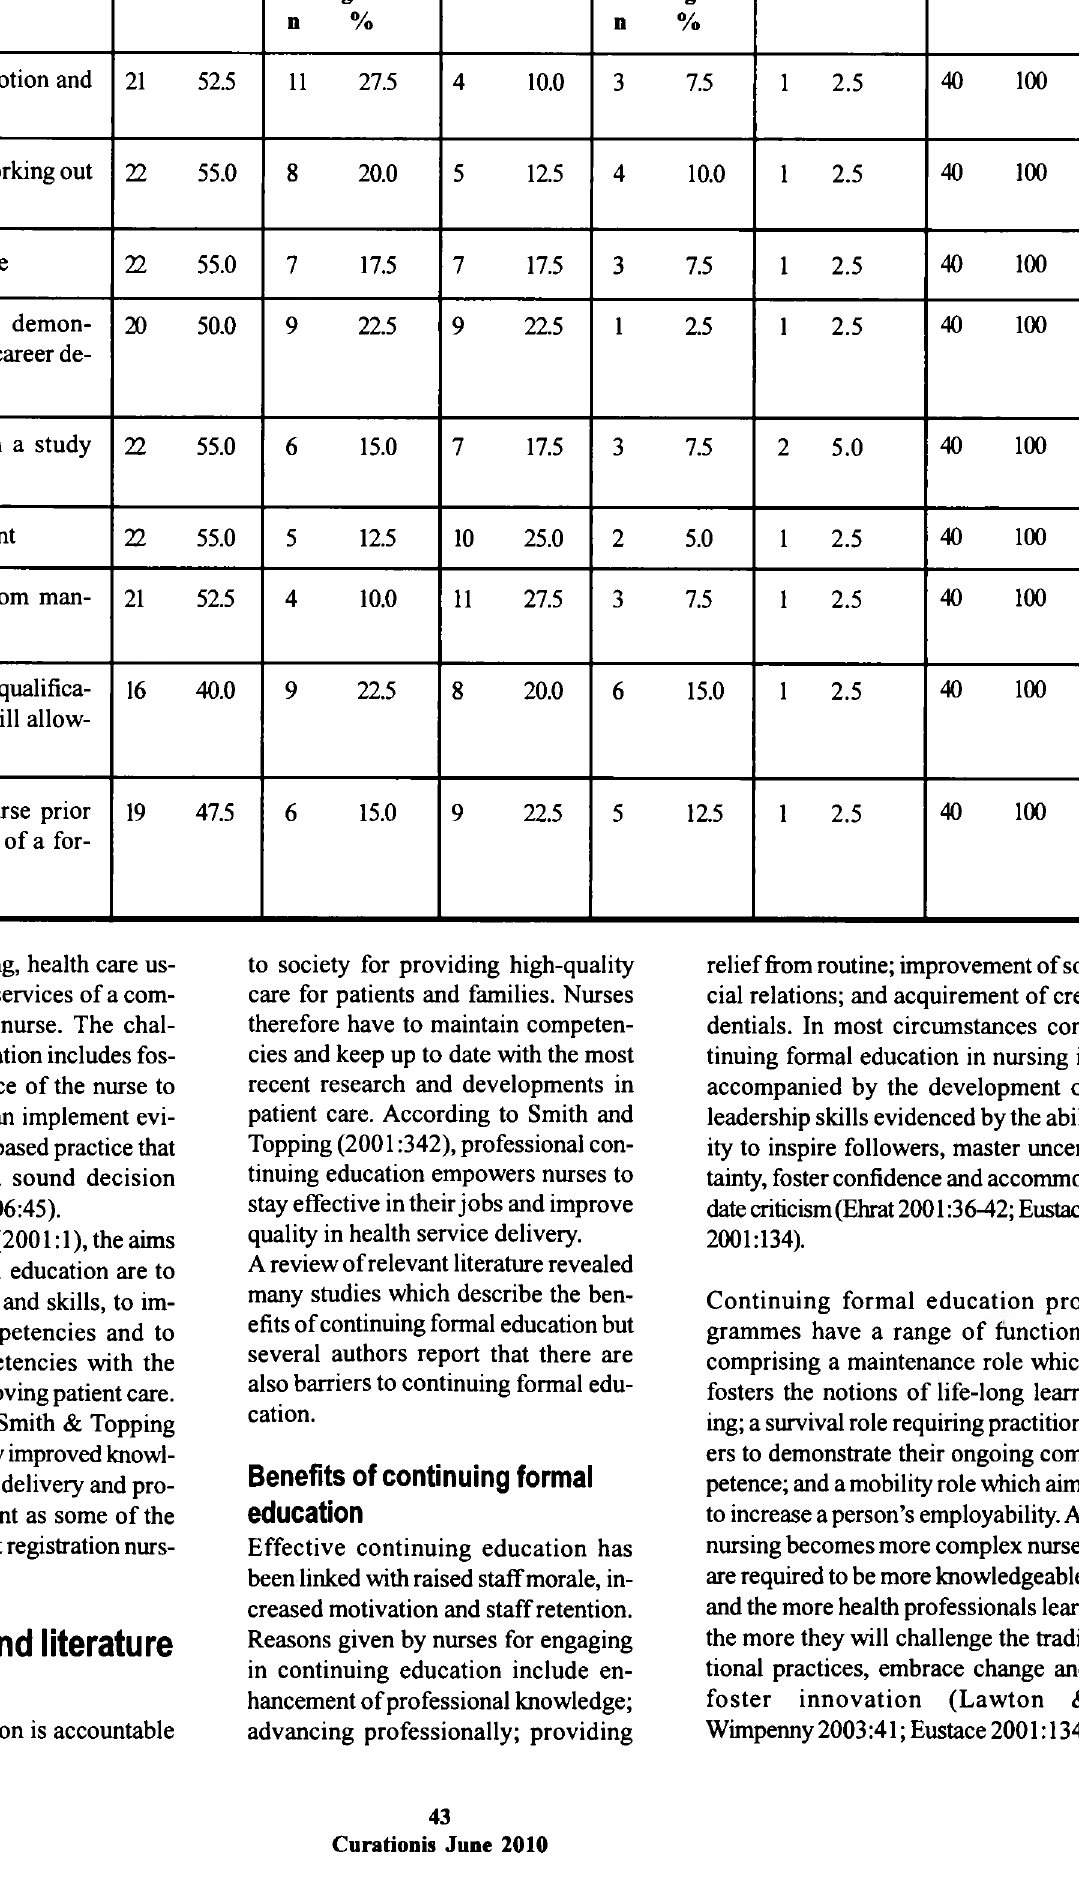
Table 2: Motivation for engaging in continuing formal education (N=40) Motivation for engaging